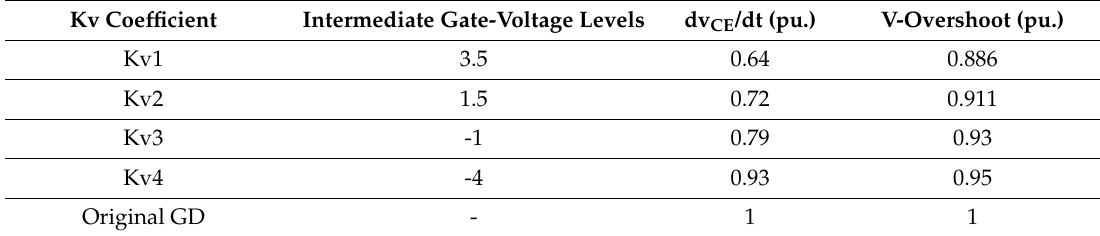
Figure 5. ( a ) The waveform of collector-emitter voltage, performed by the original gate driver. ( b ) The zoomed view to show the performance of the AGD with different Ki coefficient and its effect on the voltage at turn-off. Table 2. V CE trajectory controlled by closed-loop GD with different K V coefficients.